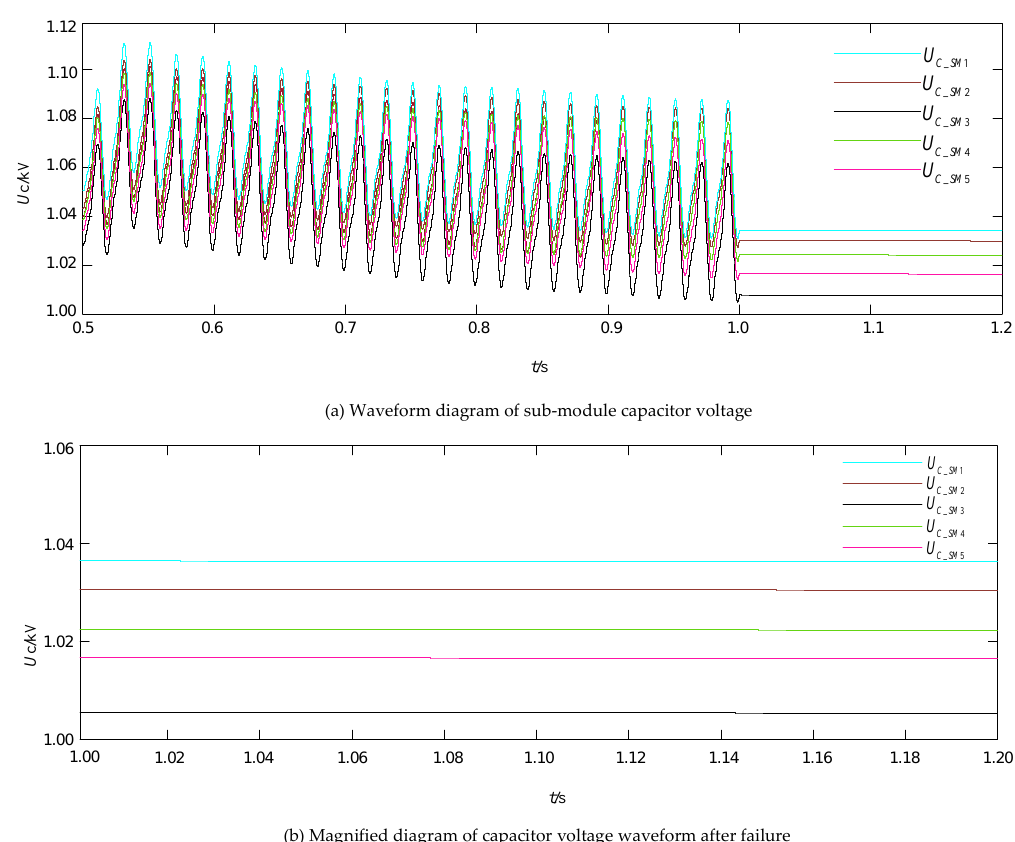
Figure 13. C 1 ≠ C 2 , capacitor voltage of sub-module: ( a ) Waveform diagram of sub-module capacitor voltage; ( b ) Magnified diagram of capacitor voltage waveform after failure.